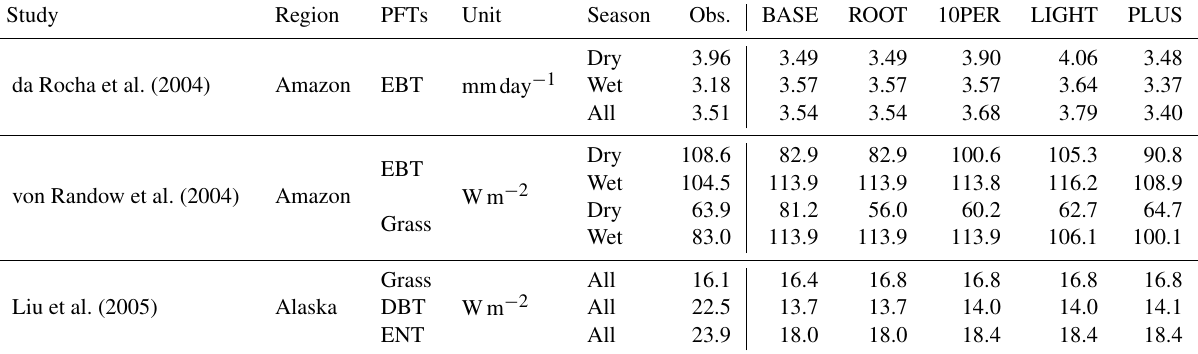
Table A6. ET and latent heat flux in situ observations from various studies and the values of the different CLM4.5 sensitivity tests at the respective